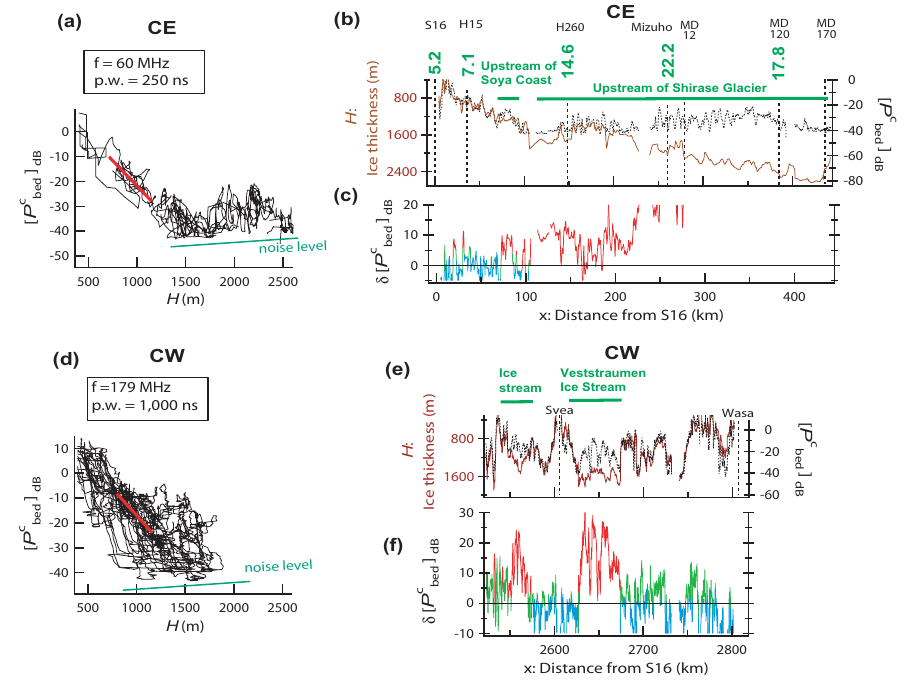
Fig. 7. (a) H-P plot along leg CE. (b) X-PH plot for the same data. The upstream area of the Soya Coast and the upstream area of the Shirase Glacier are indicated. Numbers in green indicates ice flow speeds (myr − 1 ) (Motoyama et al., 1995). (c) X- δ P plot for the same data. (d) H-P plot along leg CW. (e) X-PH plot for the same data. The locations of the major ice streams are indicated. (f) X- δ P plot for the same data.